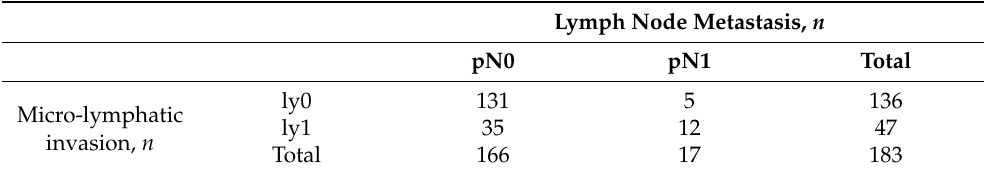
Table 5. Association between lymph node metastasis (pN) and microlymphatic invasion